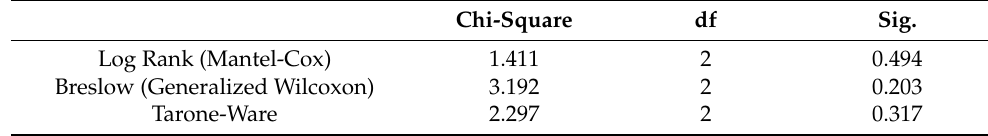
Figure 2. The survival rate of the CRC subgroups. Table 8. Test of equality of survival distributions for the different age